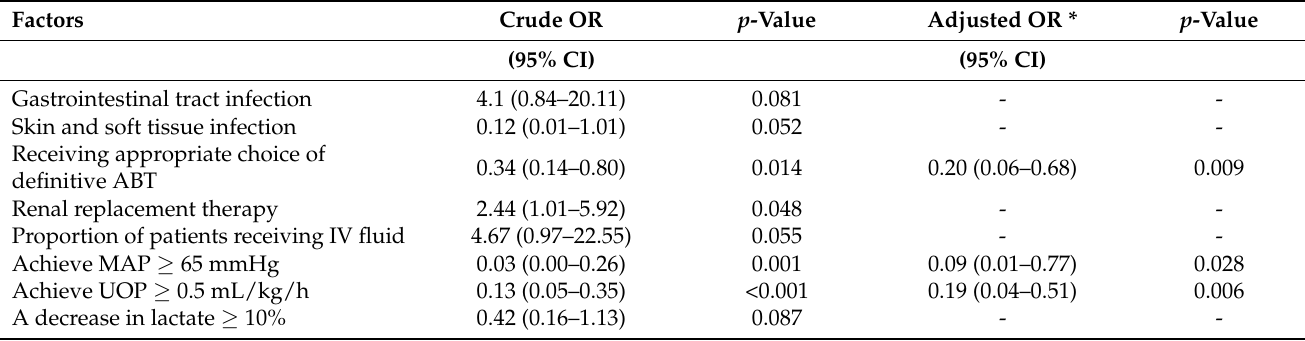
Table 5. Multivariate analysis for factors independently associated with 28-day mortality in patients with septic